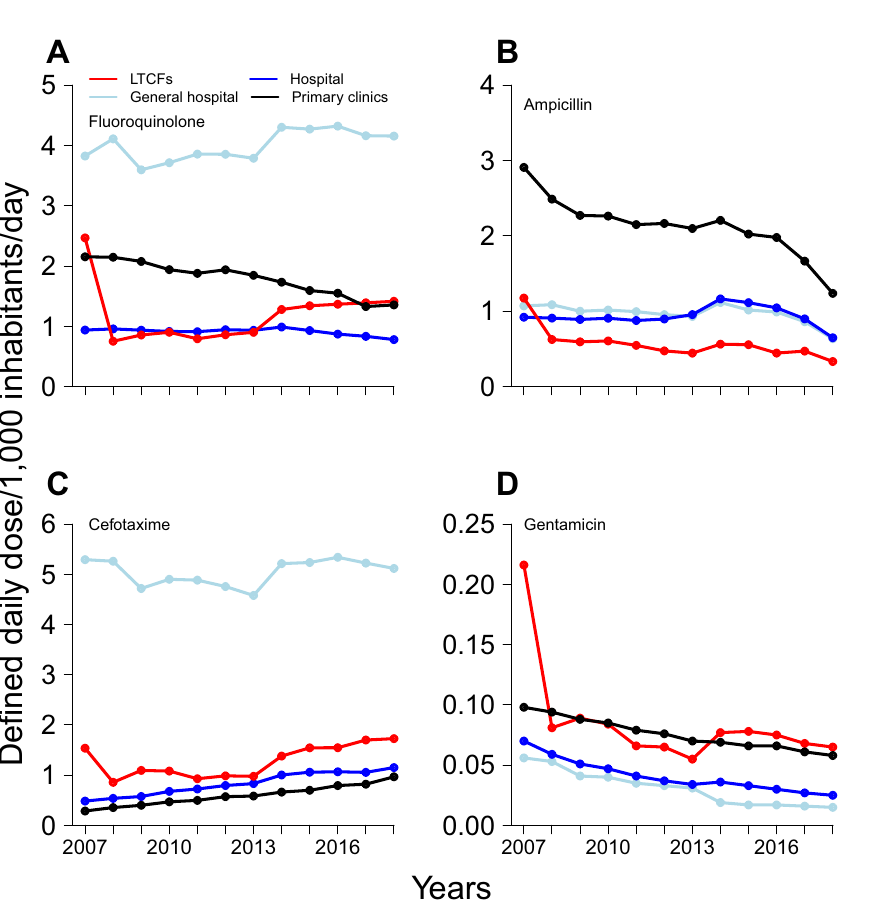
Figure 1. Prescription trend of antibiotics, including ( A ) fluoroquinolone, ( B ) ampicillin, ( C ) cefotaxime and ( D ) gentamicin, in South Korea between 2007 and 2018. The red line indicates long-term care facilities (LTCFs), and the blue line indicates hospitals. The white-blue line indicates general hospitals, and the black line indicates primary